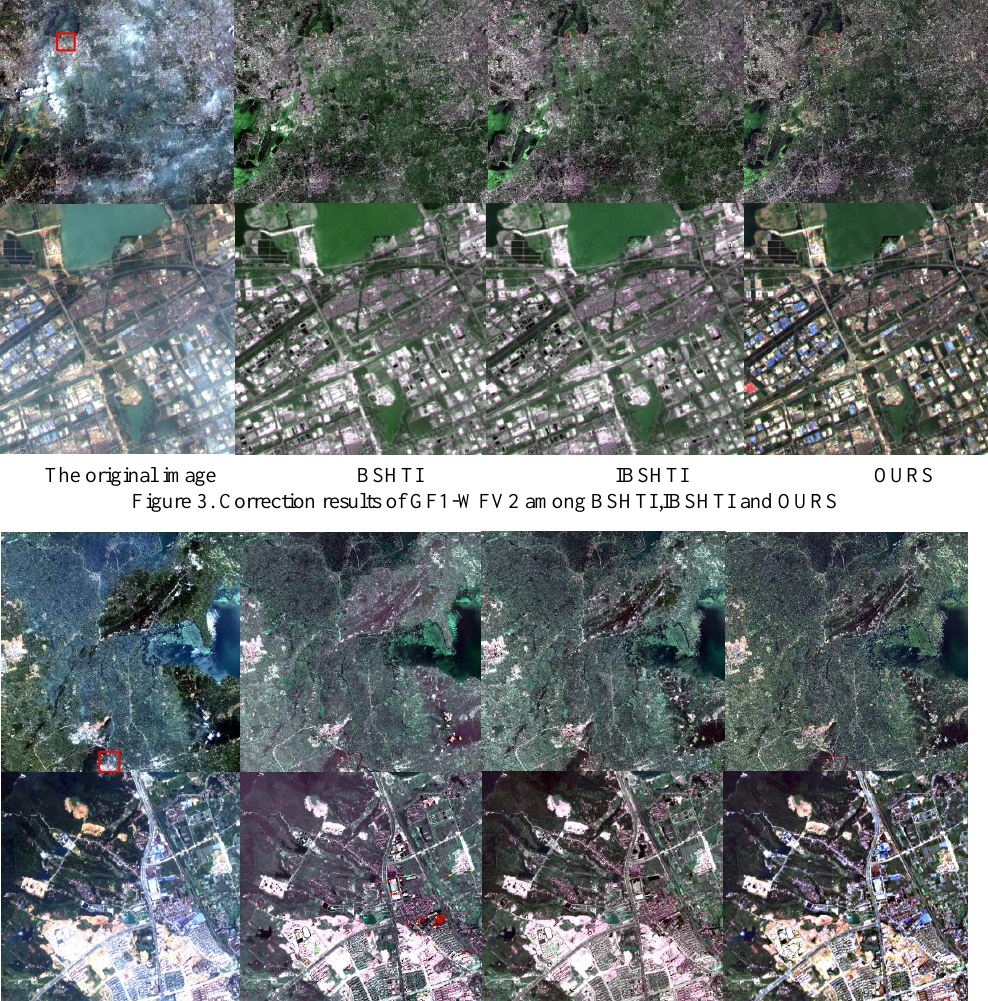
Figure 2. Correction results of Landsat8 OLI among BSHTI,IBSHTI and OURS